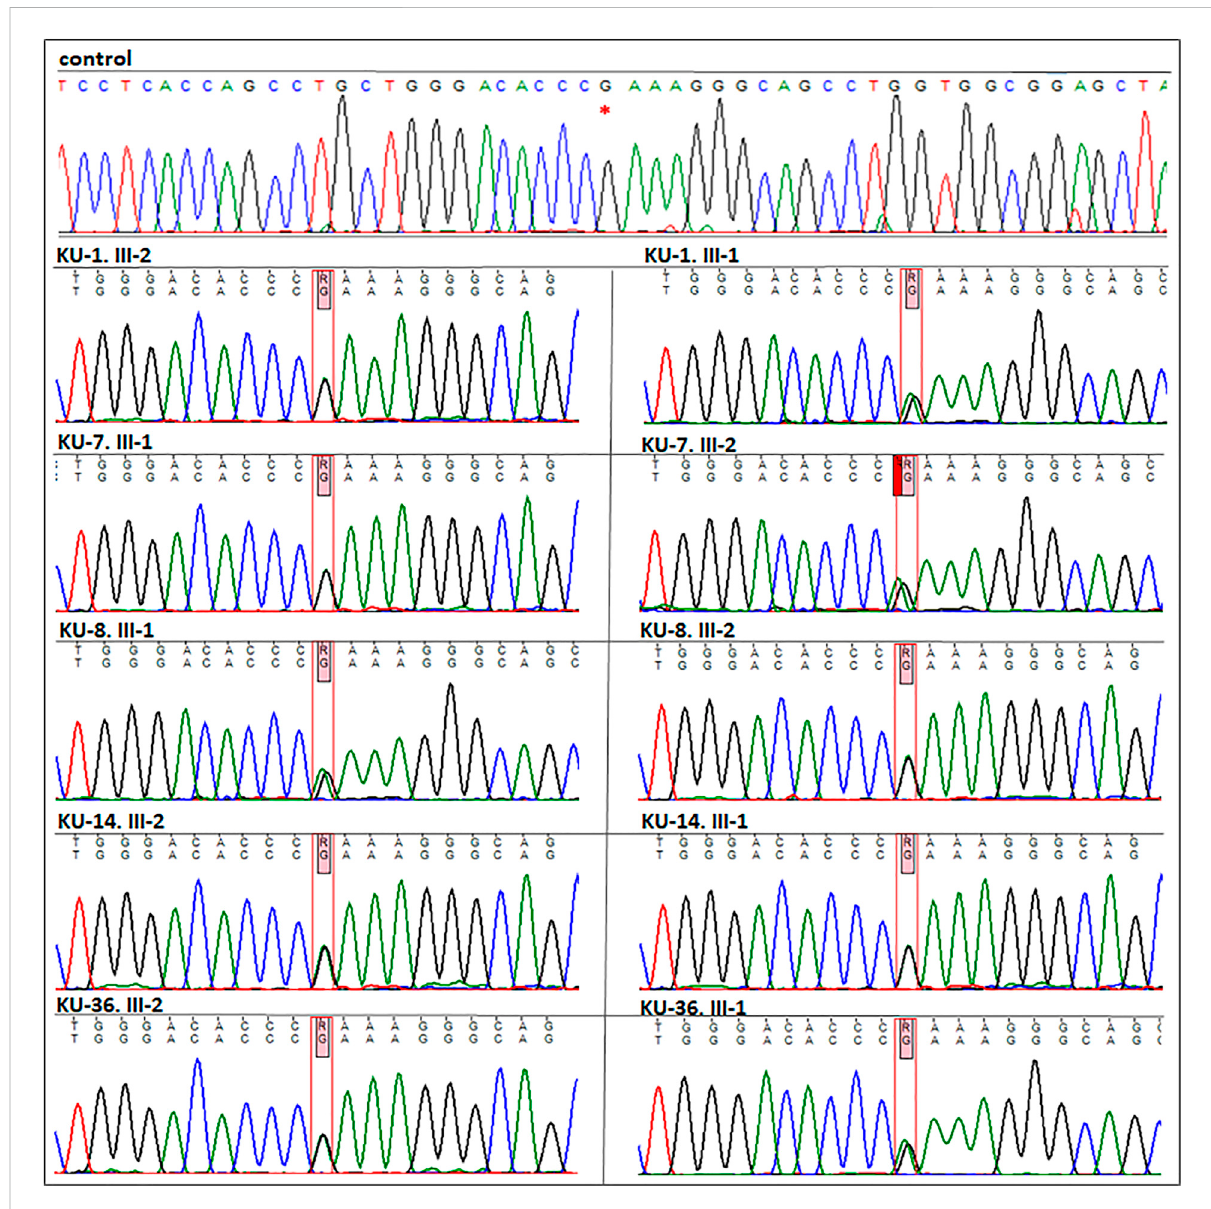
FIGURE 4 Segregationanalysisfor theparents ofthe fi vefamilies. Asseeninthis fi gurethechromatographsforthesequencingresultsfor the fi veparents, which demonstrate that all the parents are carriers for the missense variant ( DNAI2 :c.740 G > A; p.Arg247Gln) rs755060592 in exon 7. This con fi rms that the variant is segregated along with the disease phenotype in the seven PCD